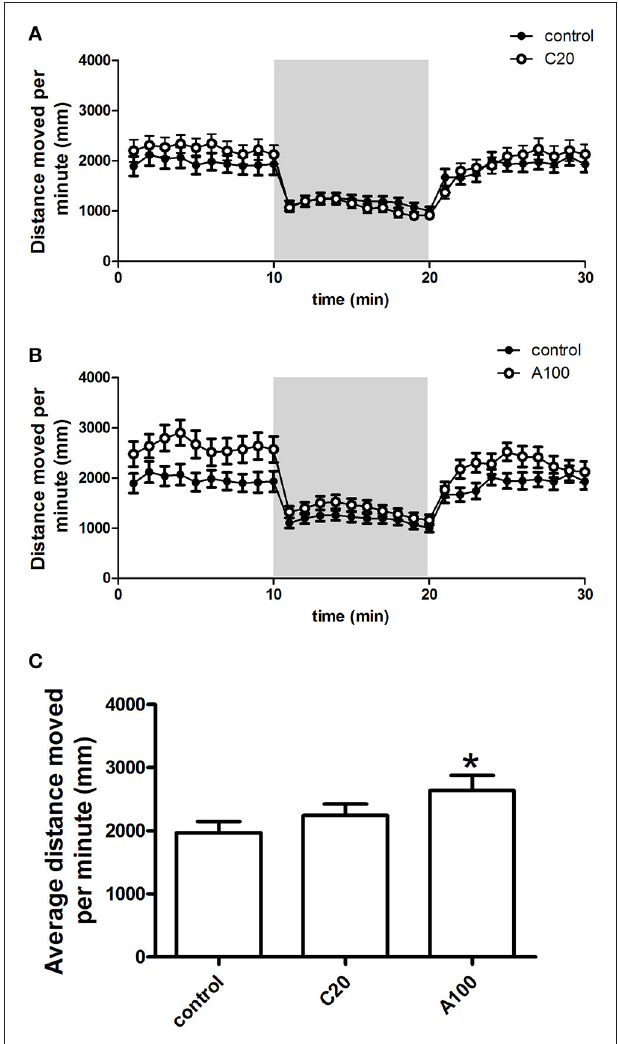
FIGURE 4 | Effects of chronic or acute exposure to VPA on the locomotor activity of zebrafish at 1 month of age. Distance moved per minute in alternating 10-min blocks of light and dark. The control group (filled circles) was plotted with chronic exposure to 20 µ M VPA (open circles) and acute exposure to 100 µ M VPA (open circles) in (A,B) , respectively. The shaded part in each panel represents the dark phase, and the non-shaded part in each panel represents the light phase. Average distance moved during the first 10-min light phase was plotted in (C) . The data are presented as the mean ± SEM, n = 32 animals per group. Statistical markers: * p < 0.05; significantly different from the